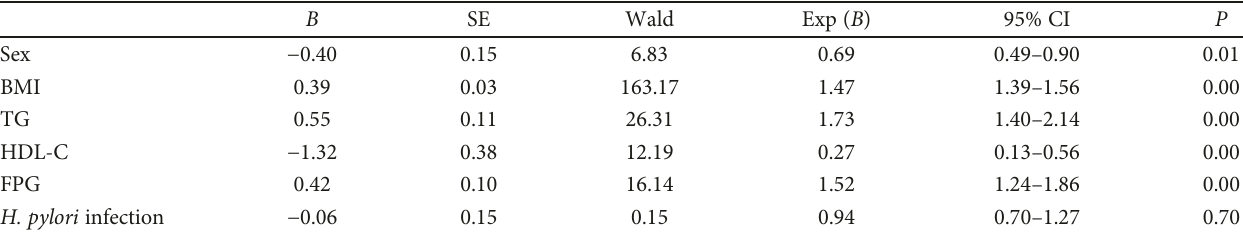
Table 3: Independent risk factors for NAFLD by regression analysis.